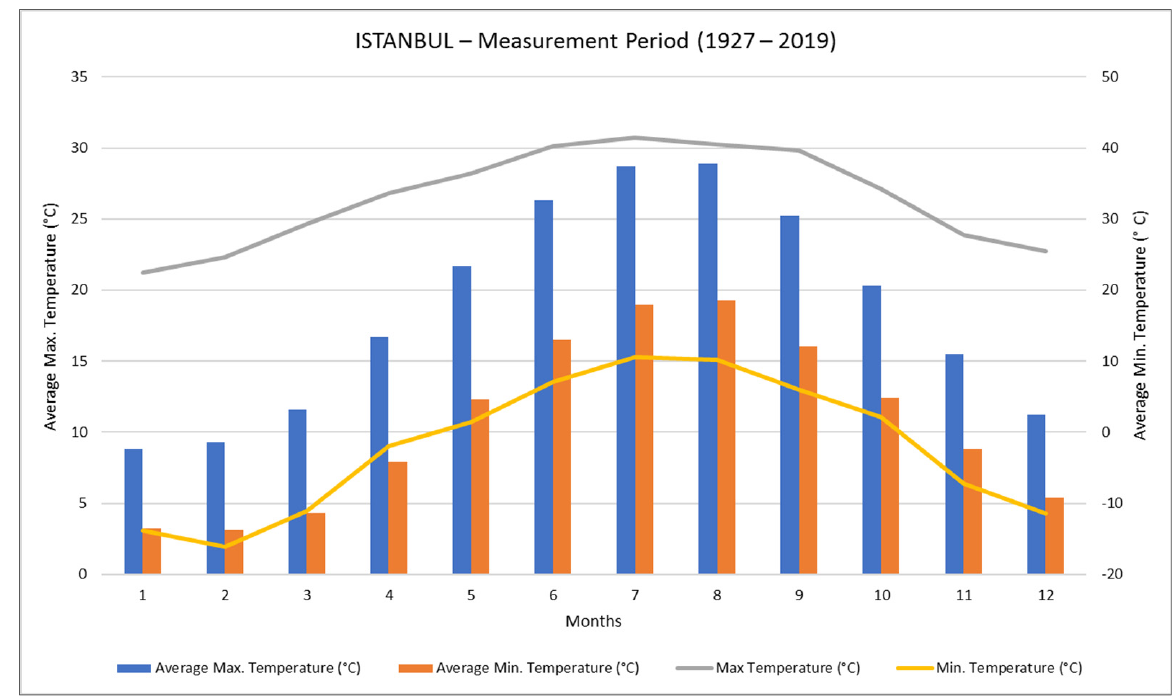
Figure 3. Annual temperature values of the Antalya (TSS 2021).